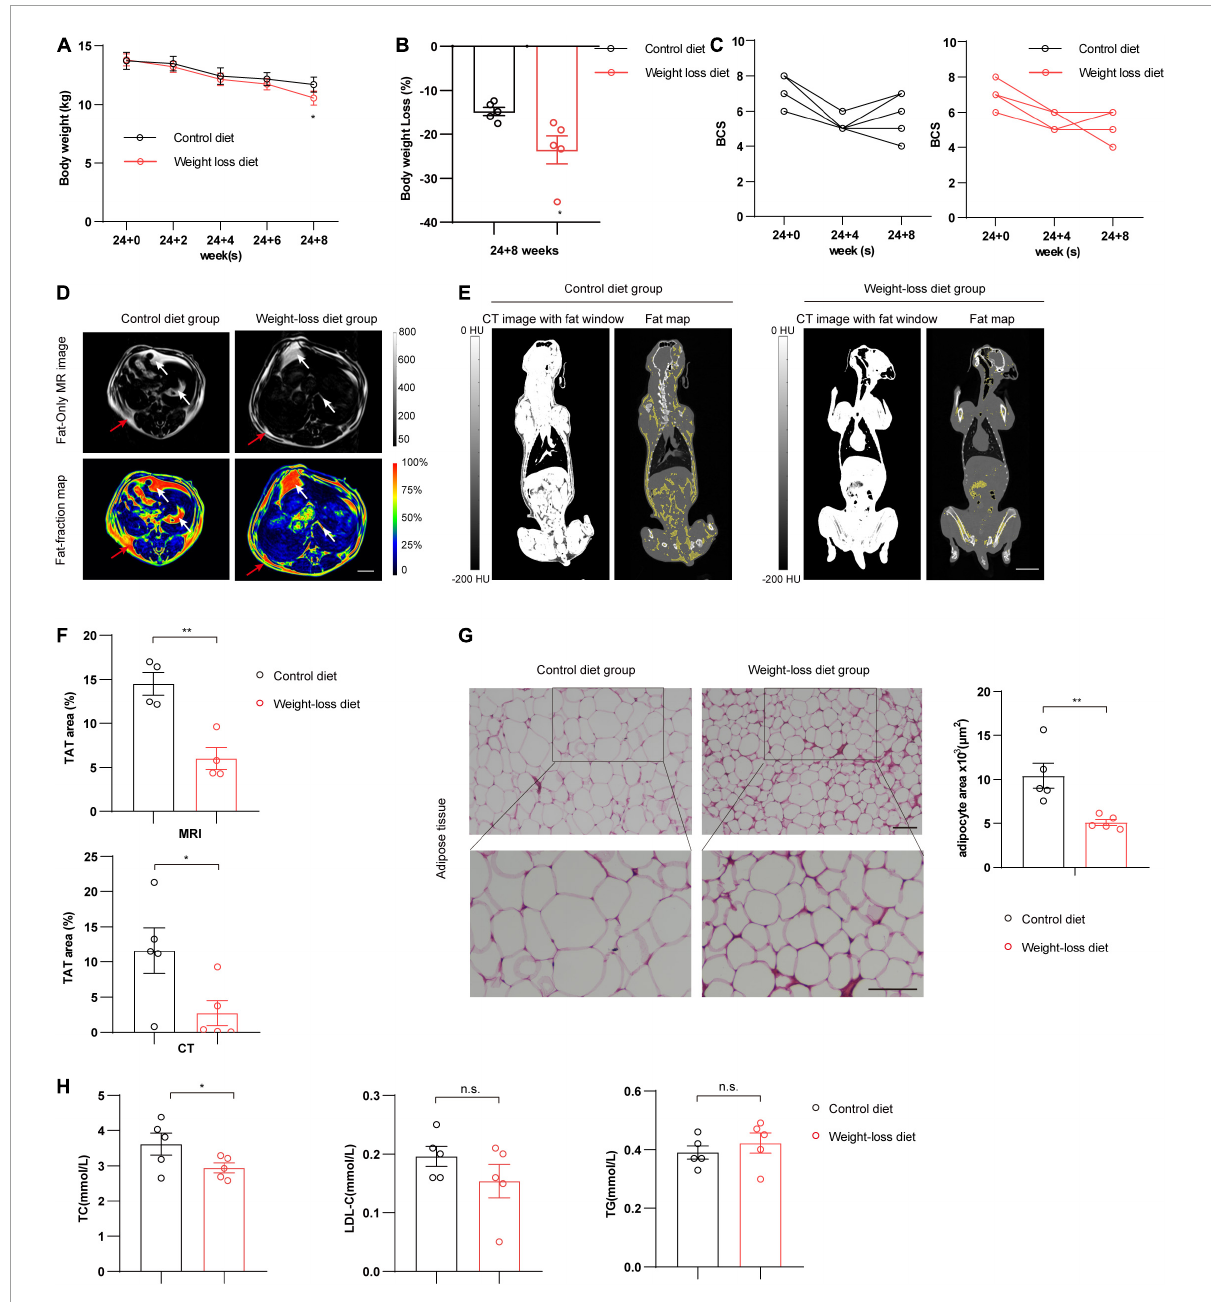
FIGURE3 Body weight and fat mass evaluation in beagles. (A–C) Analysis of body weight (A) , body weight loss (B) , and body condition scoring (BCS) (C) in beagles fed a weight-loss diet and a control diet at the indicated time points. n = 5 beagles/group. (D) Representative cross-sectional MRI showed the fat distribution in beagles at 8 weeks in the indicated groups. n = 4 beagles/group. Scale bar, 2 cm. Quantifications of TAT% based on MRI are shown on the right. n = 4 beagles/group. (E) Representative images of computed tomography (CT) showed the fat mass distribution in coronal sections in beagles fed a weight-loss diet and control diet at 8 weeks. Grayscale and pseudocolor images represent the proportion of the total adipose tissue (TAT%). n = 5 beagles/group. Scale bar, 5 cm. HU, Hounsfield unit. (F) Quantification of TAT% based on MRI and CT. TAT quantification was calculated based on the distributions of subcutaneous adipose tissue (SAT) (red arrow) and visceral adipose tissue (VAT) (white arrow). n = 4 ∼ 5 beagles/group. (G) Representative images of H&E staining in adipose tissues of control diet and weight-loss diet beagles feeding for 8 weeks. n = 5 beagles/group. Scale bar, 100 µ m. (H) Serum levels of total cholesterol (TC), triglyceride (TG), and low-density lipoprotein (LDL) in beagles fed a weight-loss diet and a control diet at 8 weeks. n = 5 beagles/group. All the data are presented as the means ± SEMs and were analyzed by Student’s two-tailed t -test. * P < 0.05; ** P < 0.01. n.s., not